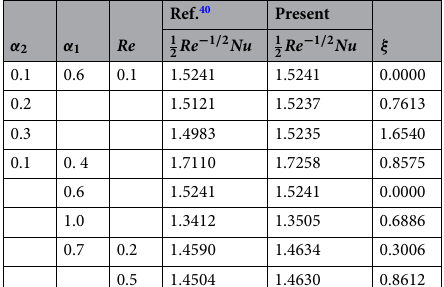
Table 3. Comparison of Nusselt number with Ref. 40 while Pr